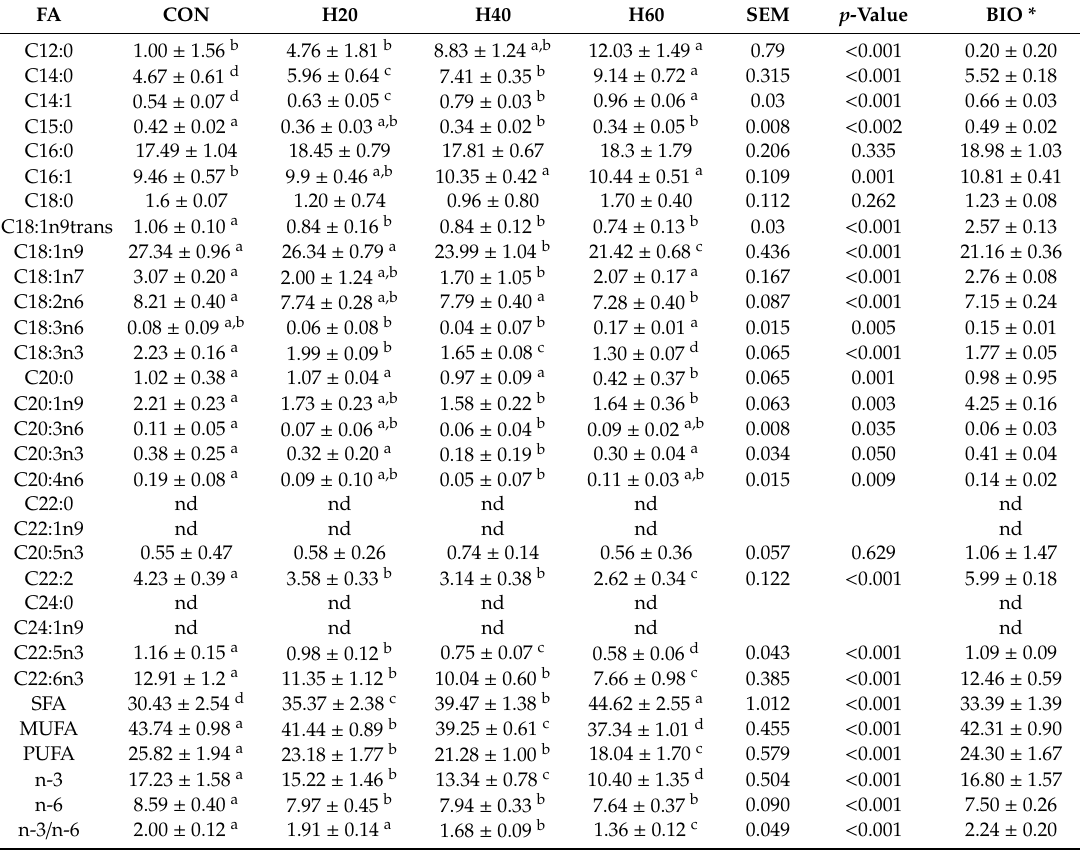
Table 7. Fatty acid (FA) profile of whole-body homogenate Eurasian perch fed experimental and commercial control diet. Data are expressed as percent of total FAs (mean ± SD, n = 9).